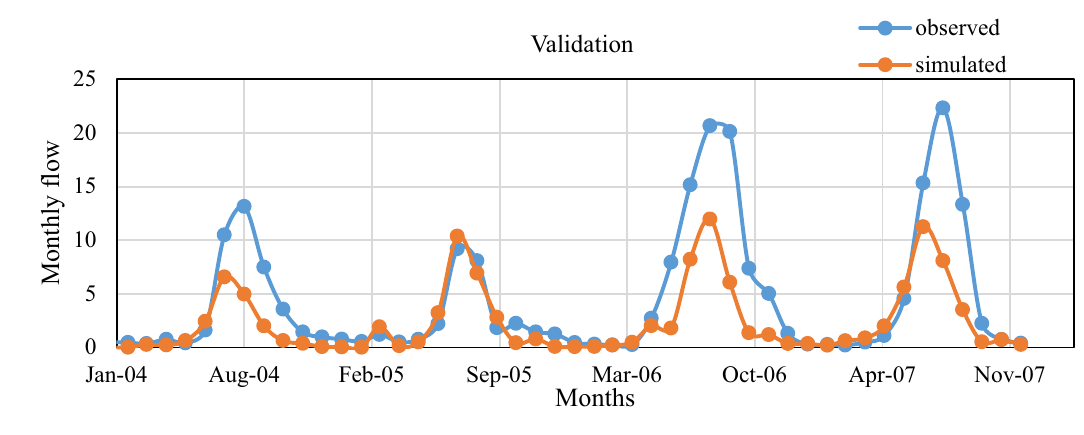
Fig. 5 Calibration and validation fitting